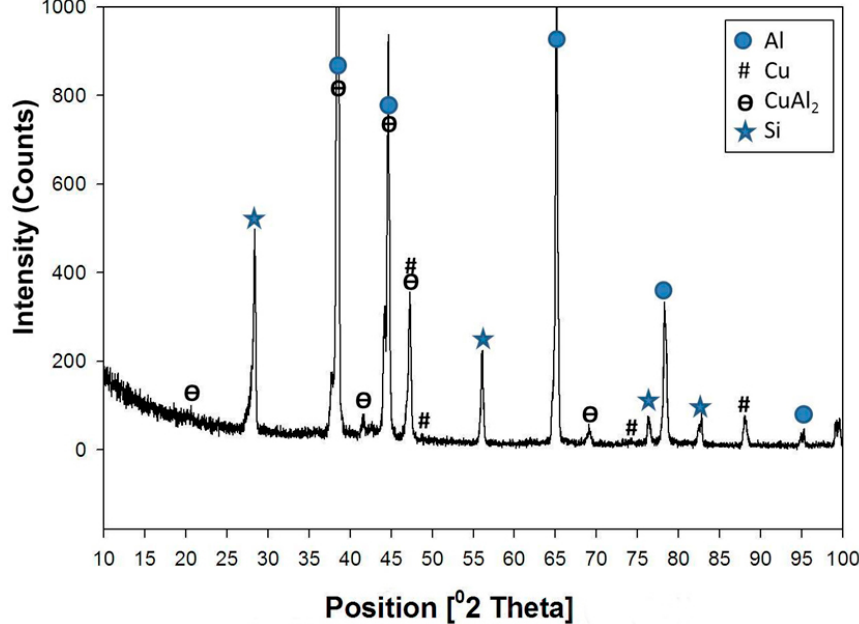
Figure 9. XRD patterns obtained from the formed composite of 6% Cu after the heat treatment at 380 °C for 6 h.